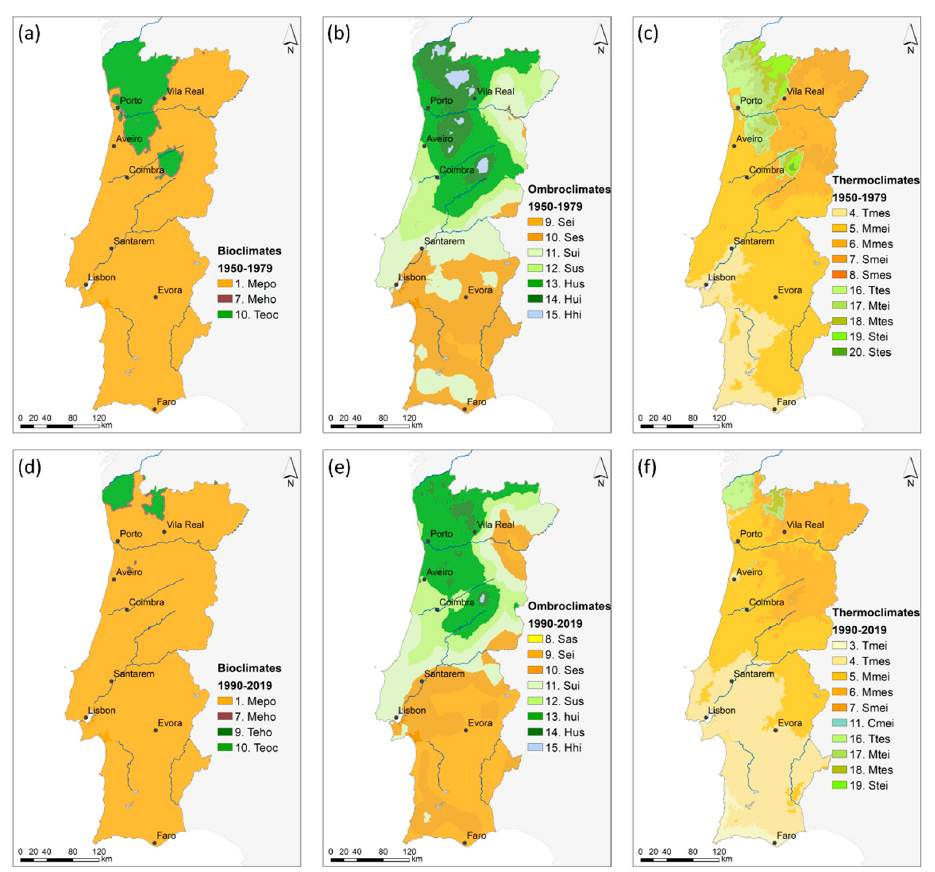
Figure 4. Classification for ( a ) bioclimates; ( b ) ombrotypes; and ( c ) thermotypes between 1950–1979 and ( d – f ) the same as for ( a – c ) but between 1990–2019. Table 6. Percentage of the territory (in %) for each bioclimate, ombrotype, and thermotype classifica- tion for mainland Portugal, for the periods 1950–1979 and